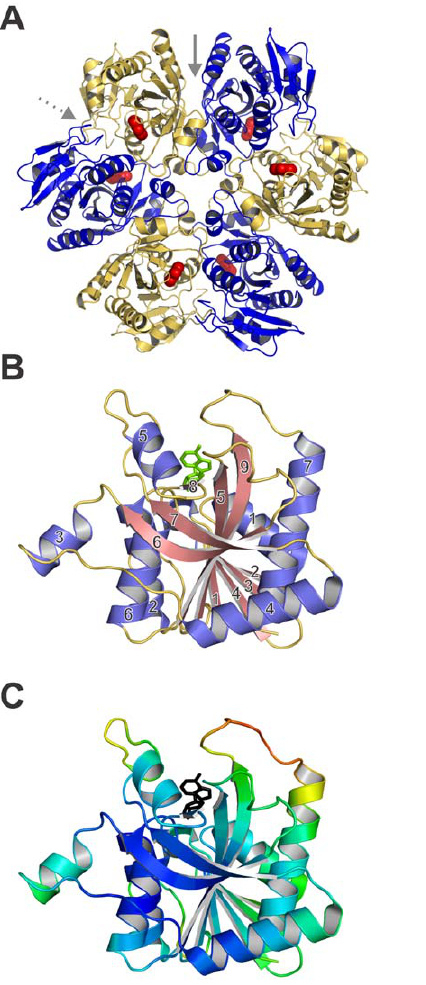
Figure 1. Overall structure of BsPNP233. A. Cartoon representa- tion of the hexamer BsPNP233 with adenine (red spheres) bound in the active site. Solid and dashed grey arrows indicate the inter-dimeric and catalytic interfaces, respectively. B. Cartoon representation of BsPNP233 protomer in complex with adenosine ( green stick). Loops, a -helices and b -strands are shown in yellow , blue and pink . The a -helices and b - strands were numbered according to the Mao and colleagues notation [50]. C. BsPNP233 protomer colored by B-factors from dark blue (lowest) to red (highest). Adenosine is represented by a black stick.